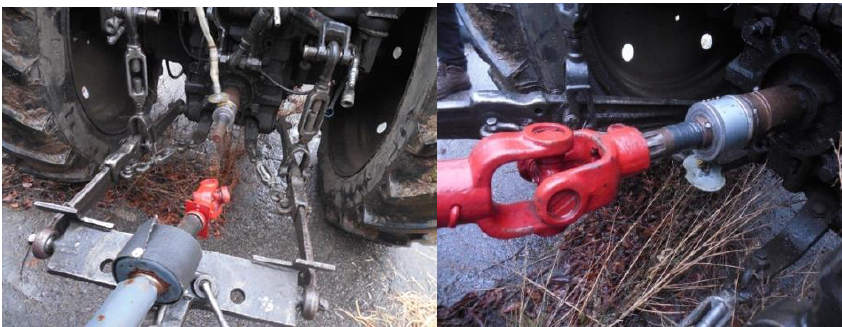
Figure 3. Determination of torque on the selection shaft tractor power.